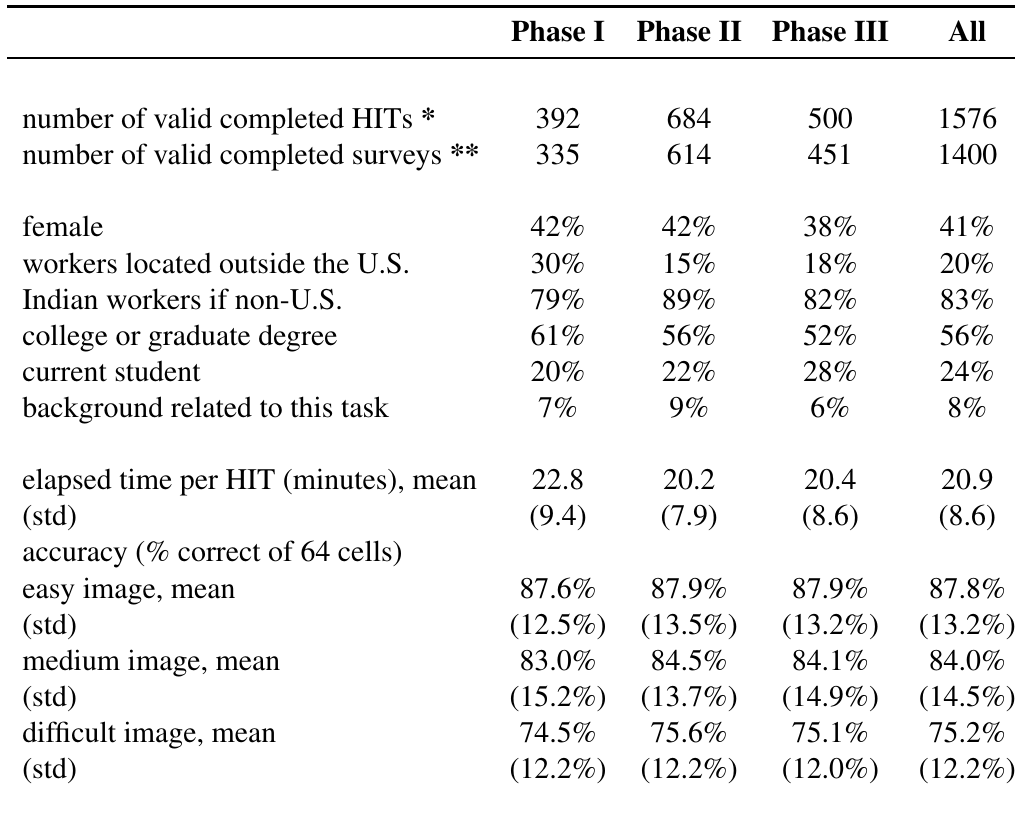
Table 2. Summary